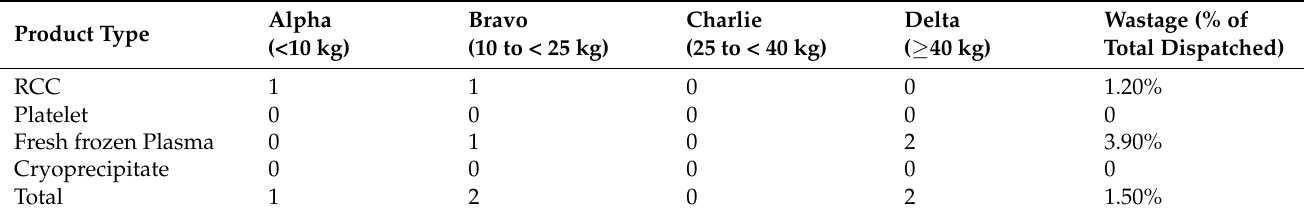
Table 2. Blood products (in terms of units) wasted by patient category.